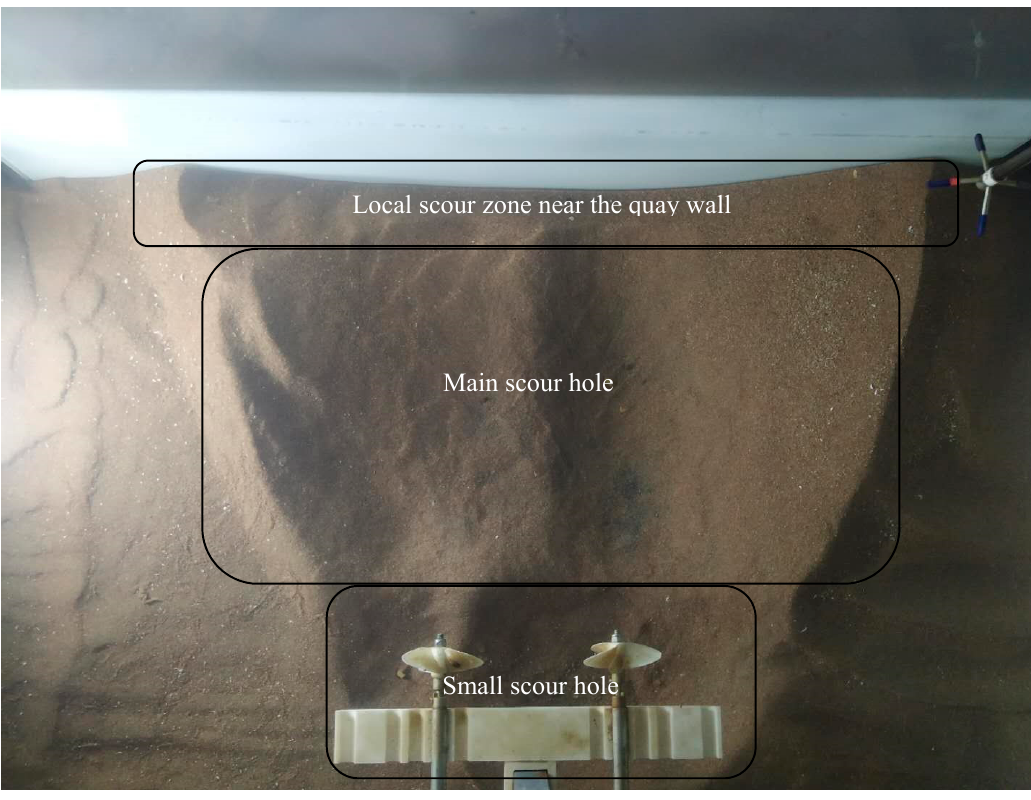
Figure 5. Scour structures of twin propellers under quay wall effect.